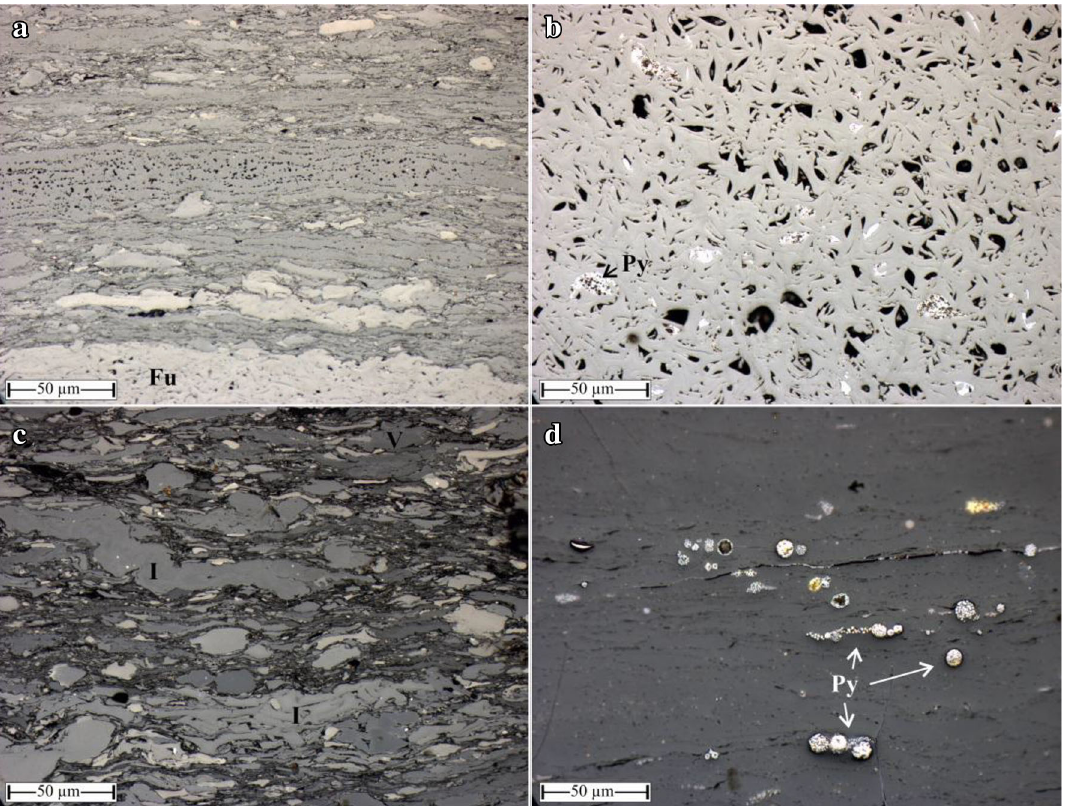
Fig. 4 Photomicrographs of coal samples of Parvadeh and Mazino coalfields (under oil immersion with reflected light): a typical vitrinite- inertinite association with fusinite (FU) of a coal sample from the Mazino area. Note the abundant pores within the telovitrinite (center), b fusinite in a Mazino coal sample with pyrite (Py) precipitated in intercellular spaces, c exemplary microphotograph of a sample from the Parvadeh deposit showing inertinite particles (I) and gelovitrinites (V) in a matrix of detrovitrinite and clay minerals, d framboidal pyrites in vitrinite in a Parvadeh coal